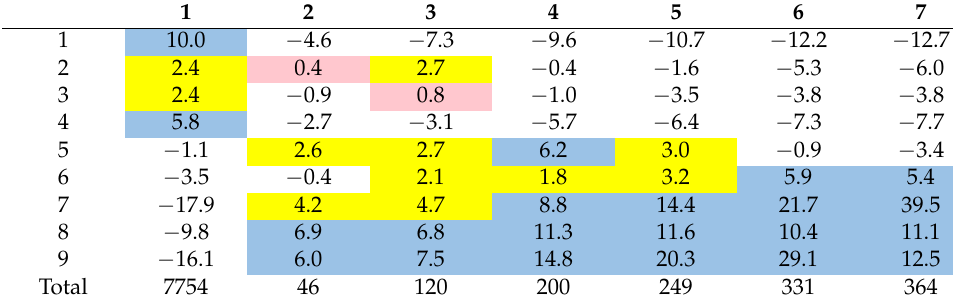
Table A11. Theoretical frequencies CUF 2006 (C1/Class_111).